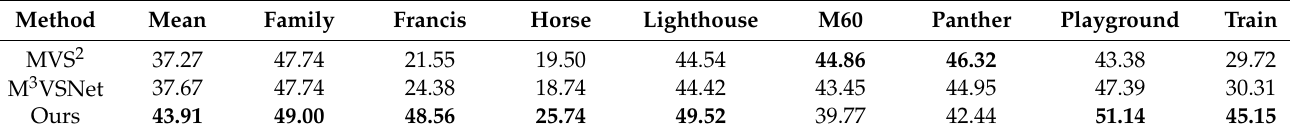
Table 4. Result on Tanks and